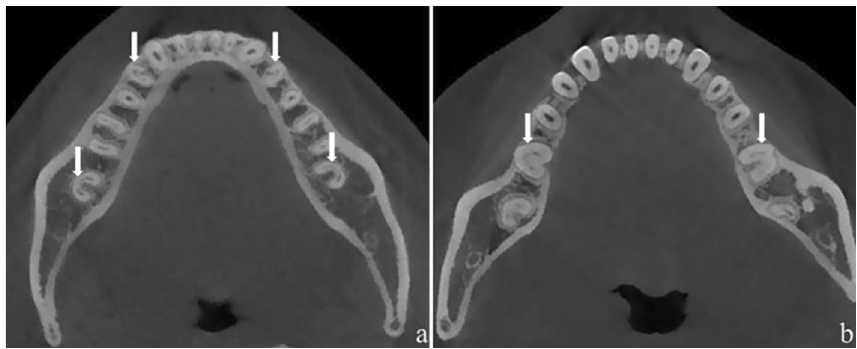
Figure 2. ( a ) Bil-CSRCs in MFPs and MSMs, ( b ) Bil-CSRCs in MFMs.